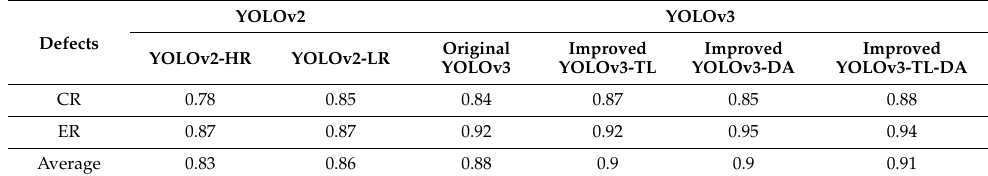
Table 3. Detection precision (AP) of the YOLOv2 and YOLOv3.